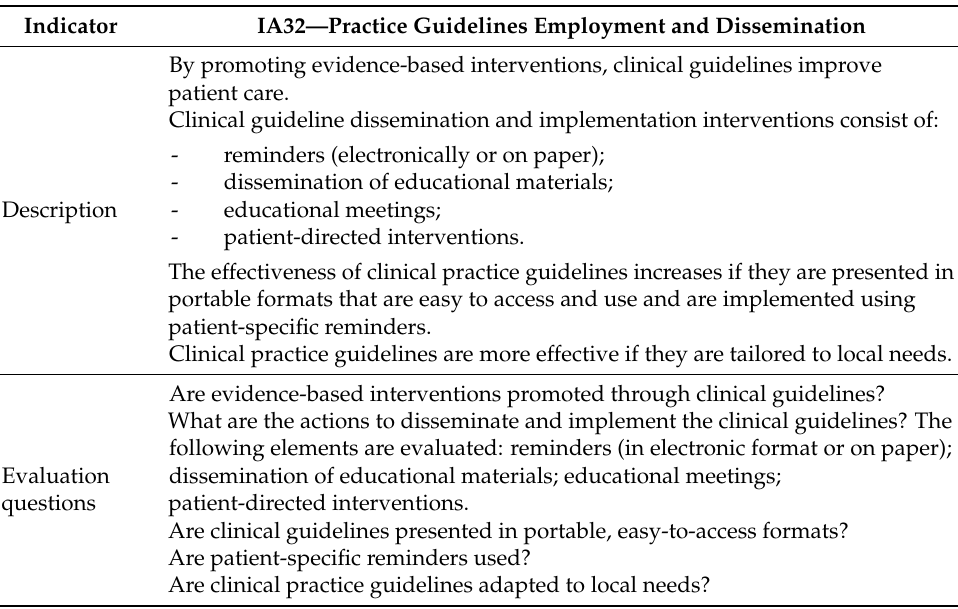
Table A7. The indicator IA32—Practice guidelines employment and dissemination. Indicator